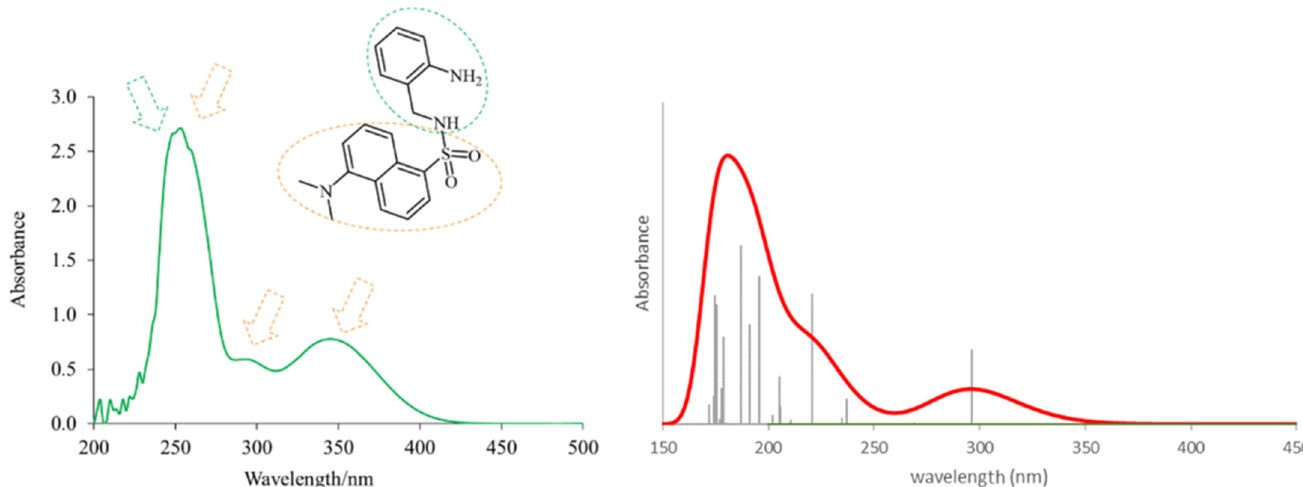
Figure 3. Experimental ( left ) and theoretical ( right ) profiles for the electronic spectrum of DsA. The signal assignment of the two moieties of the molecule has been included as a schematic. The orange arrows show the bands associated with the dansyl moiety, and the green arrow shows the band associated with the aniline moiety. Vertical lines indicate individual electronic transitions listed in Table 1.